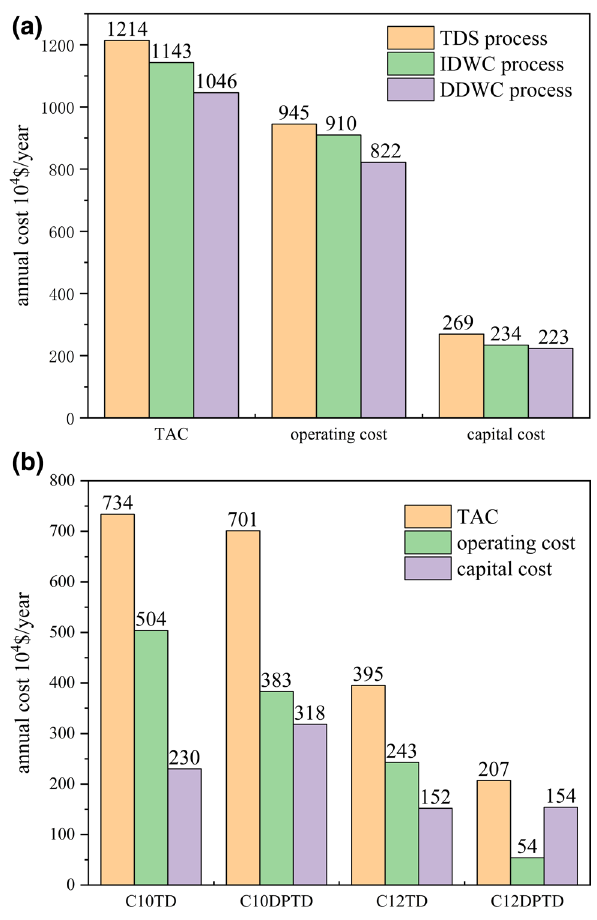
Fig. 7 TAC of two separation procedures for F–T heavy oil. a TAC of F–T oil separation process, b TAC of narrow fraction separation process Table 3 Summary of TAC of normal olefins and alkanes’ separation processes